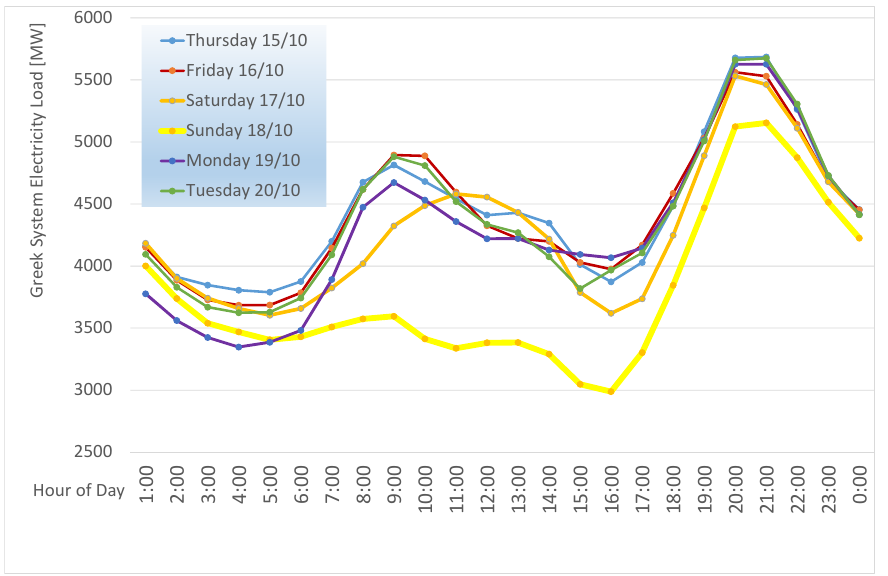
Figure 13. Hourly variation of the electricity load of Greece during 6 days of mid-October 2020 [69].